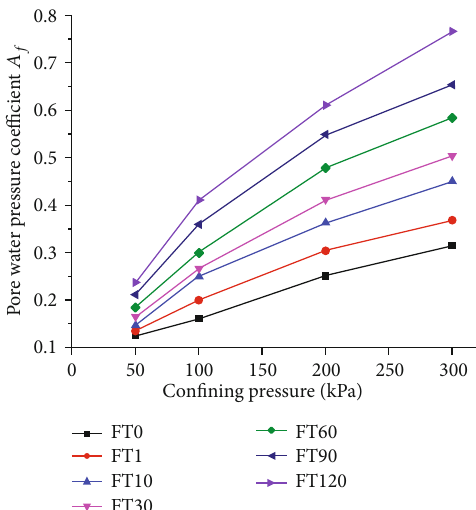
Figure 6: Pore water pressure coe ffi cient in shear failure of specimens under di ff erent